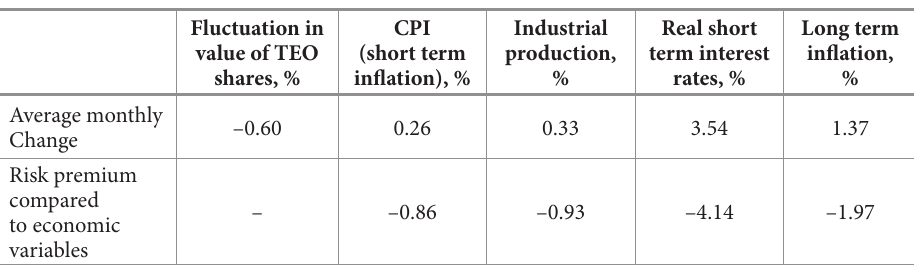
Table 6. Average monthly fluctuation from June, 2000 to December, 2008